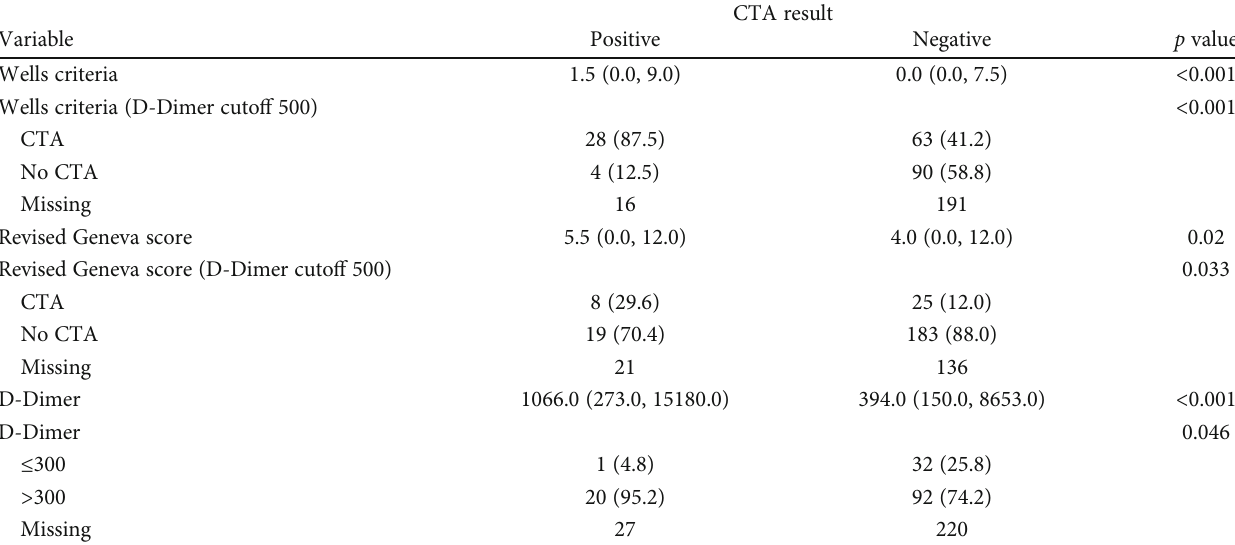
Table 3: Wells criteria, revised Geneva score, and D-Dimer association with CTA. Median (range), N (%).